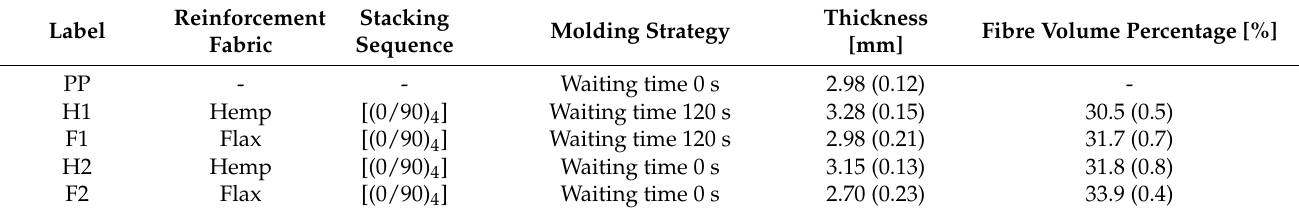
Table 1. Main properties of samples, mean values and standard deviations (between